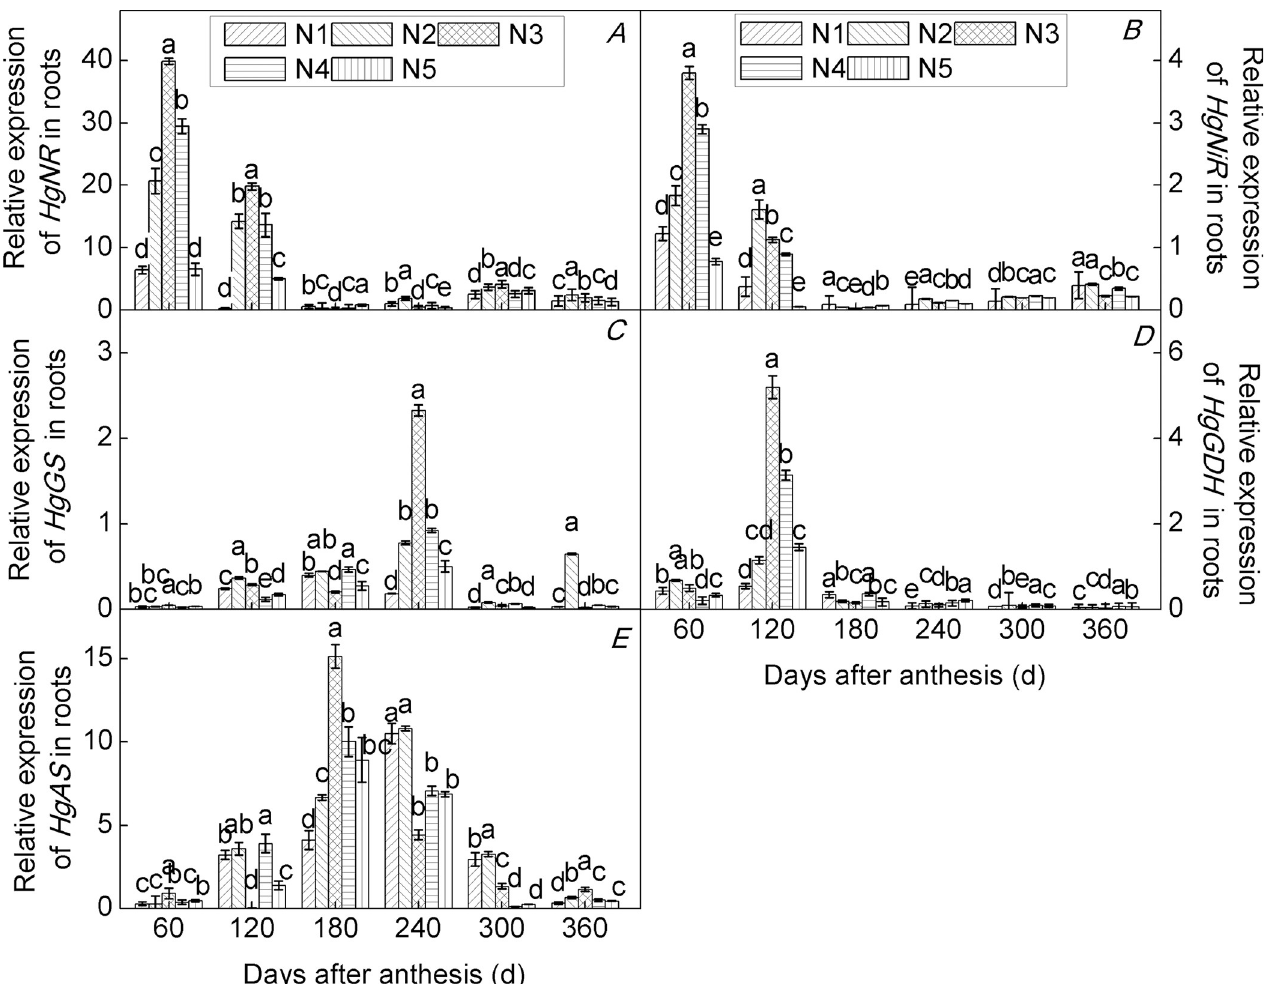
Fig 3. Relative gene expression in roots of the citrus cultivar ‘Huangguogan’. HgNR (nitrate reductase, A), HgNiR (nitrite reductase, B), HgGS (glutamine synthetase, C), HgGDH (glutamate dehydrogenase, D), and HgAS (asparagine synthetase, E). N 1 : 0, N 2 : 1.36, N 3 : 1.81, N 4 : 2.26, N 5 : 2.72 kg/year of N fertilizer [CO(NH 2 ) 2 , N �